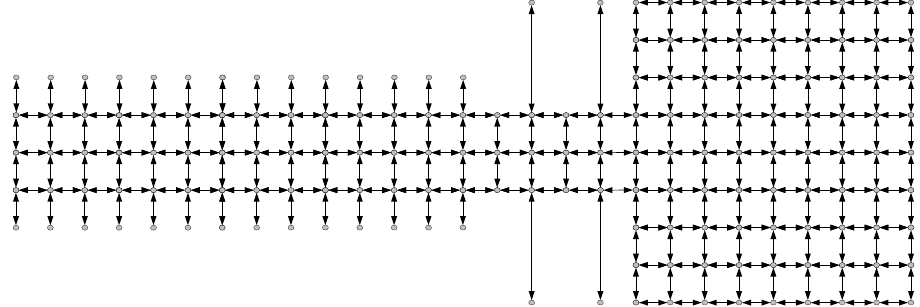
Figure 1. Factory topology map in the automated guided vehicle (AGV) system.